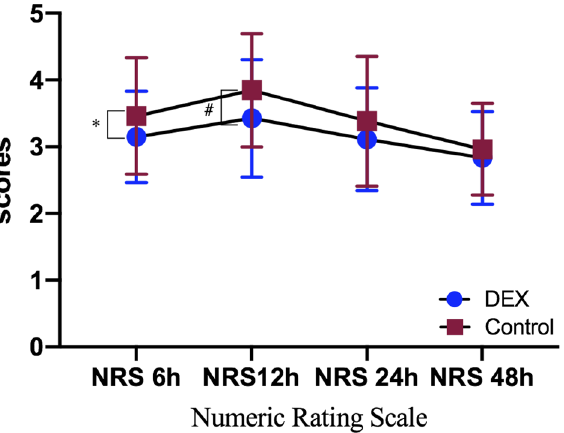
Figure 3. The postoperative pain scores of the dexmedetomidine group were significantly lower than those of the control group at 6 h and 12 h after surgery. The scores are presented as mean and standard deviation. DEX